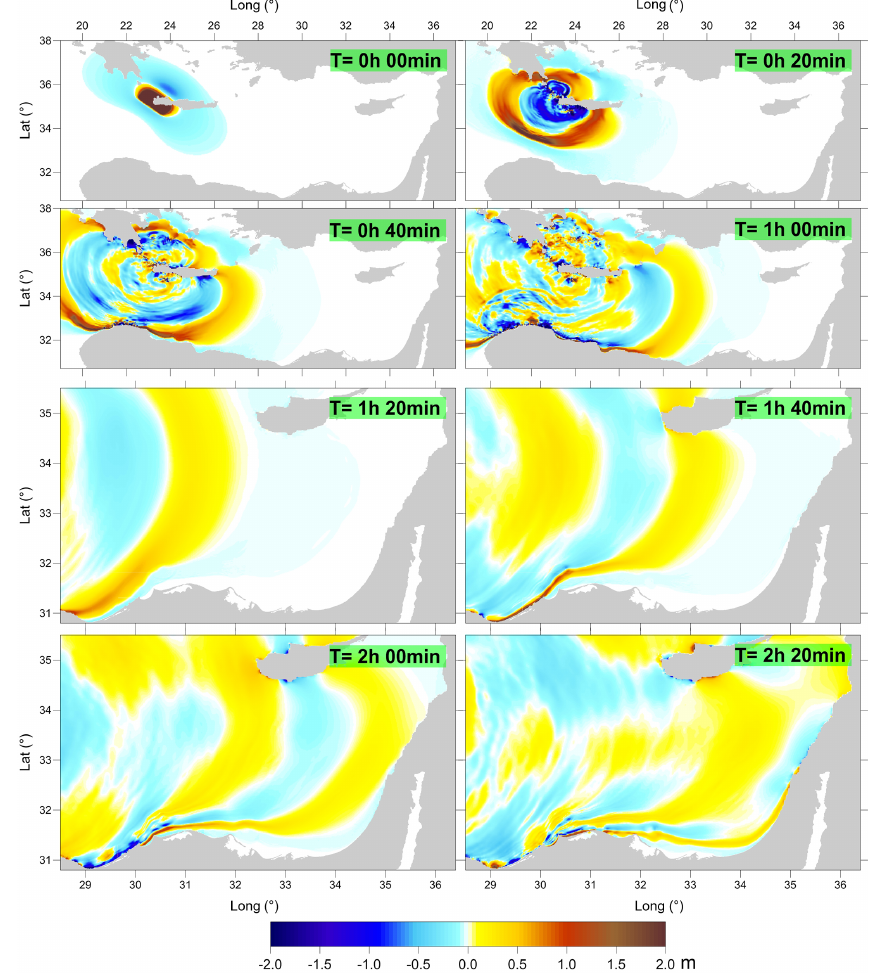
Figure 5. Propagation fields for the WHA tsunami scenario. Snapshots taken every 20min. Fields from t = 0 to t = 1h are plotted in grid 1; the other ones are plotted in grid